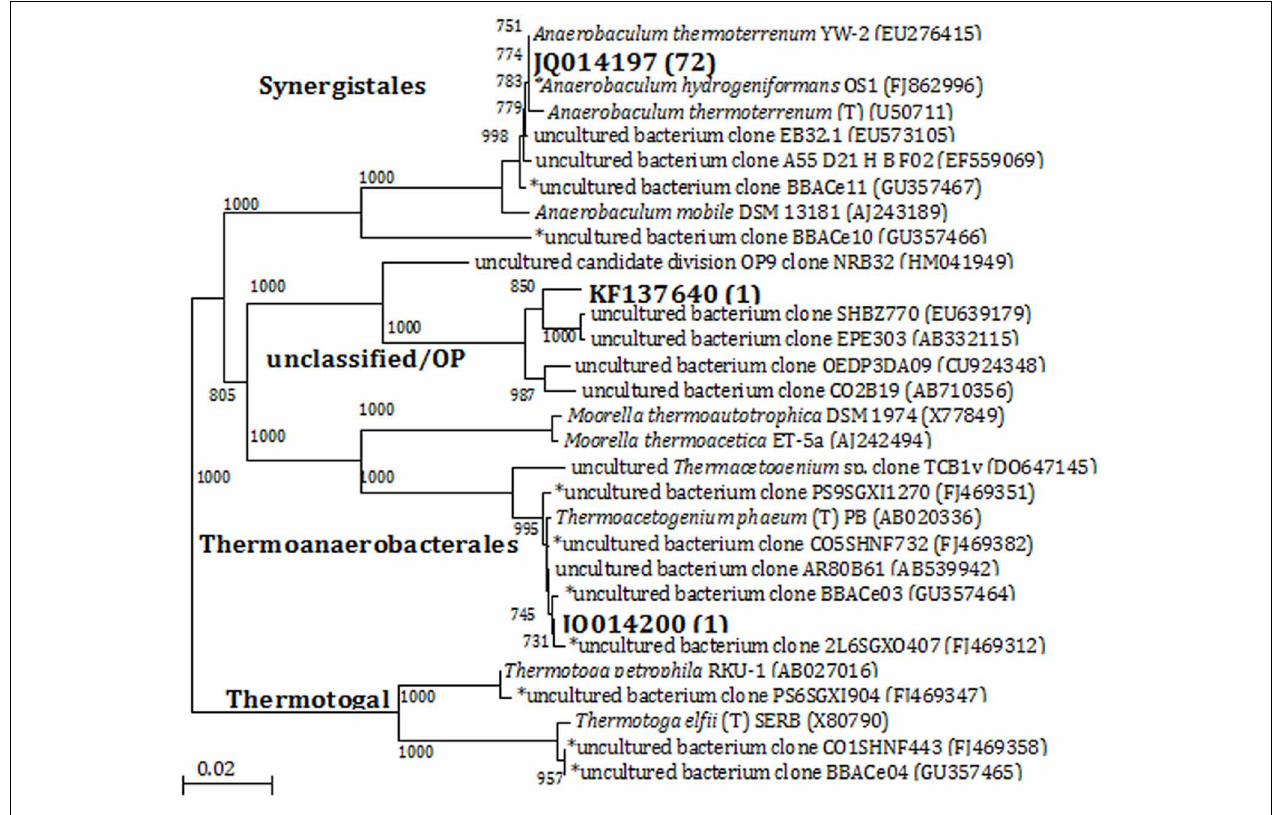
FIGURE 2 | Phylogenetic relationships of bacterial 16S rRNA gene sequences obtained from enrichments by the 4th transfer. The tree is constructed from approximately 1300 bp 16S rRNA gene sequences using the neighbor-joining algorithm. One thousand bootstrap replications were performed; only values greater than 700 are shown. The accession numbers shown in bold are of representative sequences from the current study; the